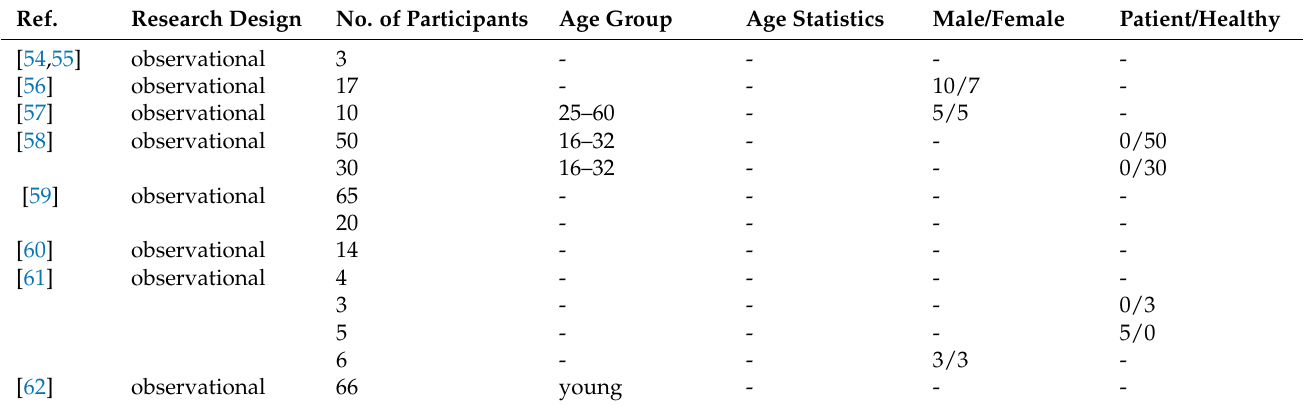
Table 5. Participant demographics for studies on physical activity recognition. - = no information.